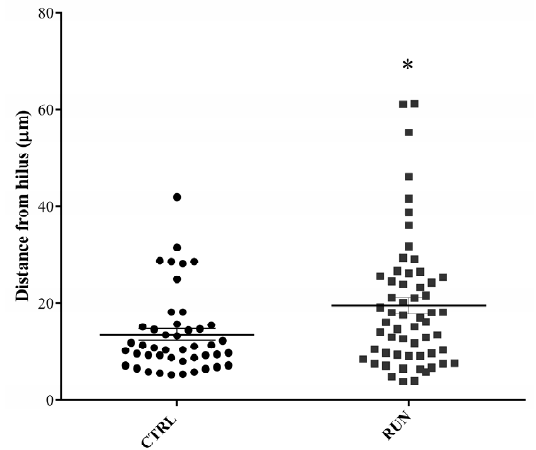
Figure 7. Adult-generated granule neurons migration assessment. Newborn granule cell body position within the granule cell layer was analyzed by measuring the distance between each GFP-positive cell body and the SGZ/hilus zone. Many newborn granule cells in the dentate gyrus of the RUN group migrated farther from the considered zone compared to controls. Data statistical analysis: unpaired Student’s t -test, * p < 0.05. All data are expressed as mean ± SEM, CTRL n = 44, RUN n = 57. It is noteworthy that in plotting the cell body distance from the SGZ/hilus versus the dendritic length, it was possible to distinguish two separate populations of labeled cells in the RUN group that we named RUN1 and RUN2 (Figure 8B). The presence of subpopulations was not appreciable in the CTRL group (Figure 8A).